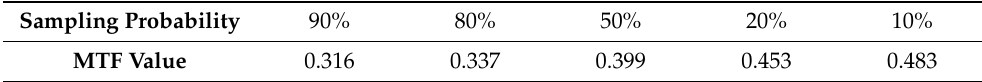
Table 4. Results of the Monte Carlo